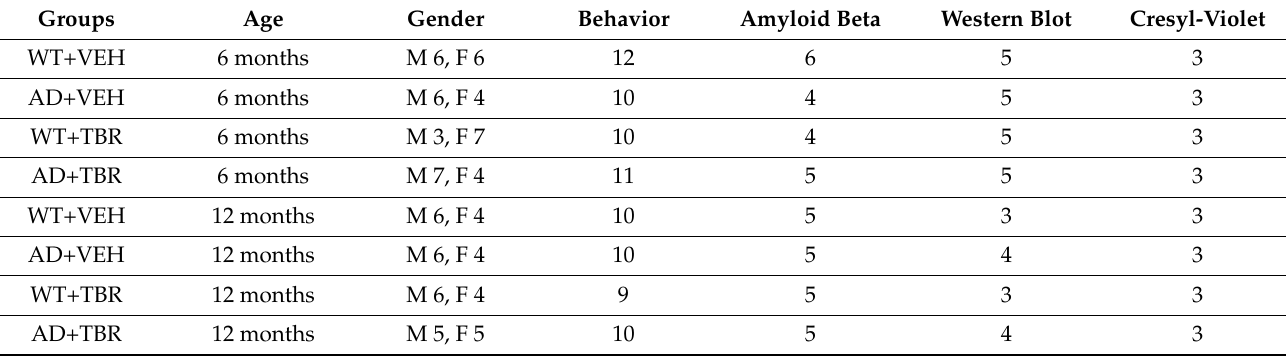
Table 1. Experimental groups. Schematic diagram showing experimental design and treatment paradigm. Distribution of 6- and 12-month-old 5xFAD and age-matched WT mice for each procedural group. Groups